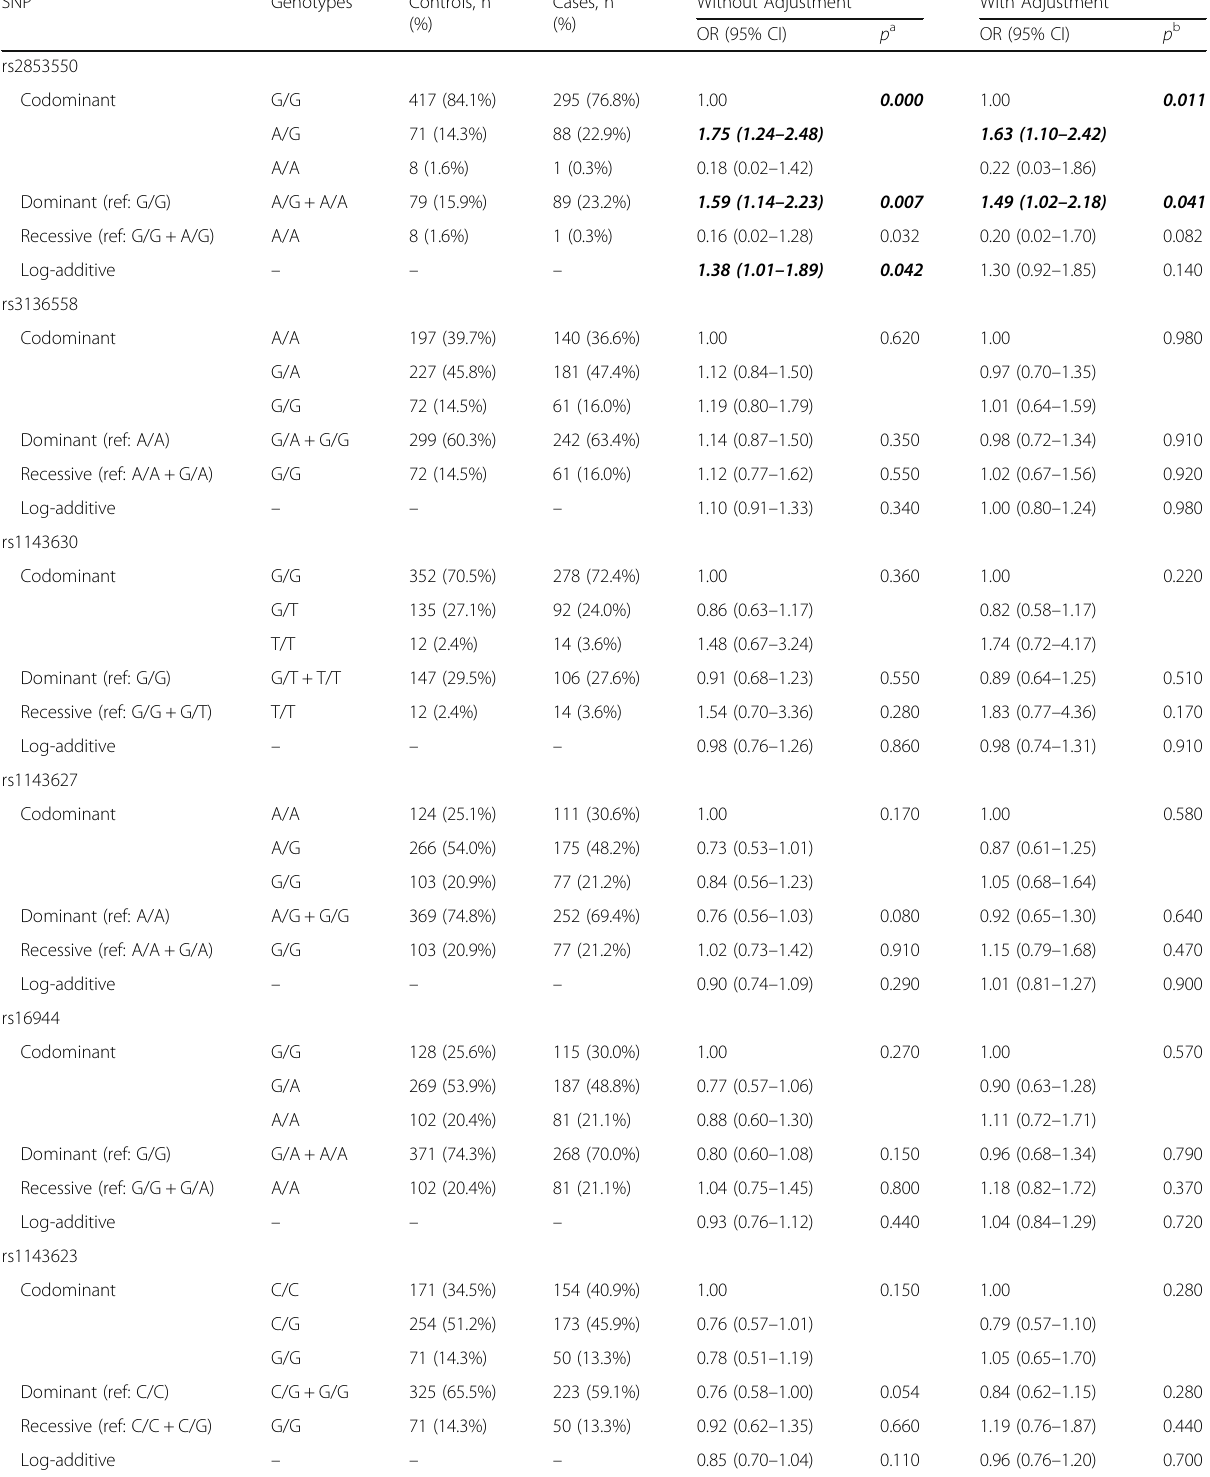
Table 3 IL-1B SNPs and risk of EC with or without adjustment for gender and age SNP